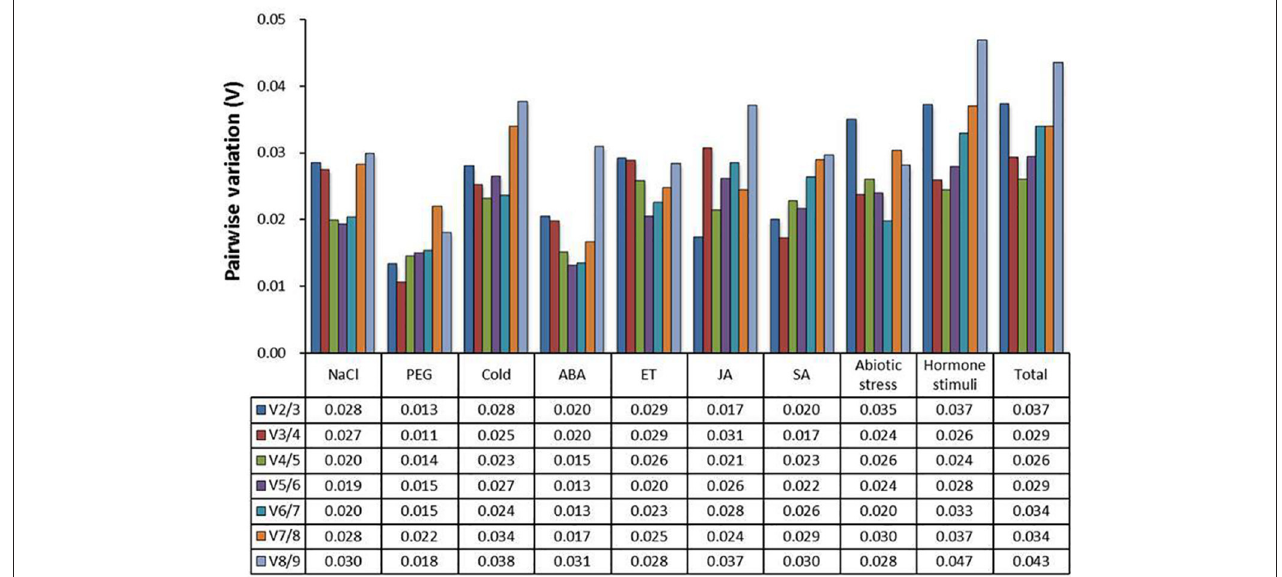
FIGURE 2 | Pairwise variation (V) of candidate reference genes calculated by geNorm. Pairwise variation (V n /V n + 1 ) was calculated between normalization factors NF n and NF n + 1 to determine the optimal number of reference genes. “Abiotic stress” includes NaCl, PEG, and Cold. “Hormone stimuli” includes ABA, ET, JA, and SA. “Total” represents all samples.